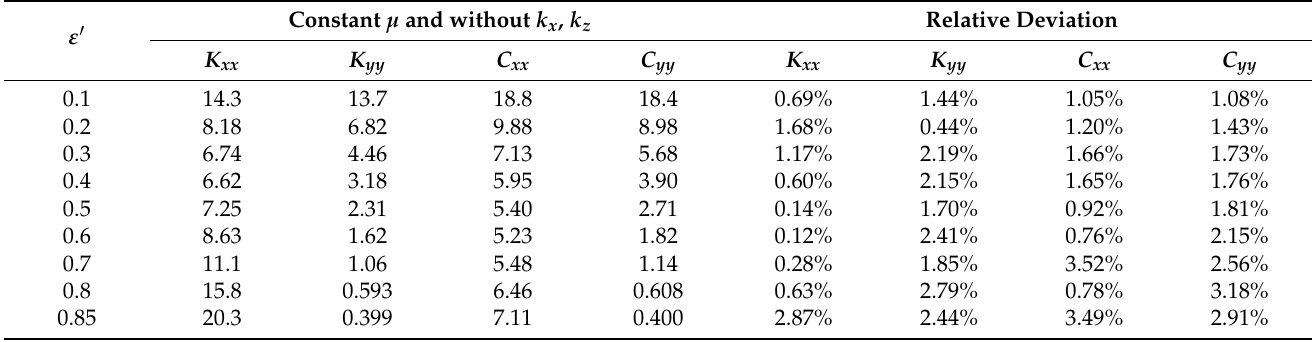
Table 1. The validation of the dynamic characteristics program for the tilting pad